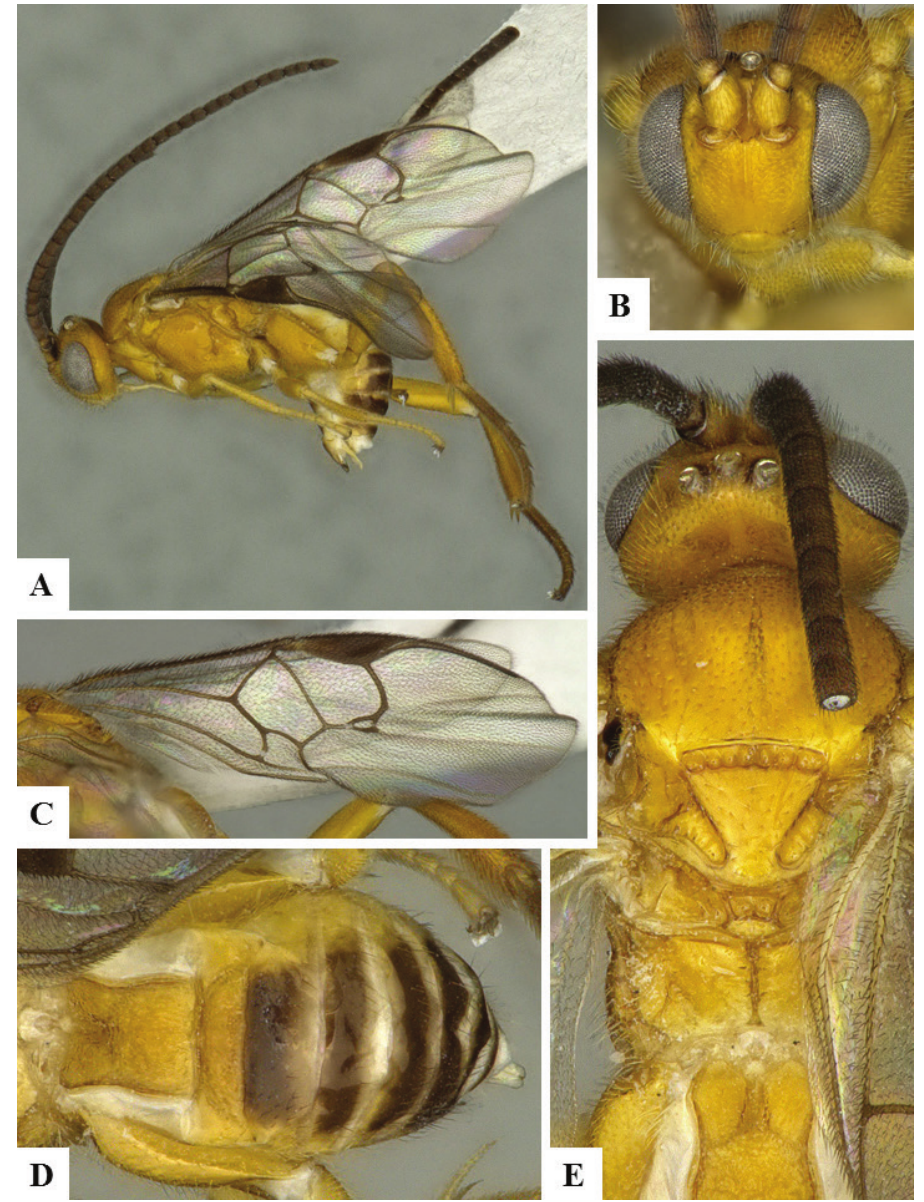
Figure 43. Ypsilonigaster sharkeyi male holotype. A Habitus B Head frontal C Fore wing D Metasoma dorsal E Head and mesosoma,